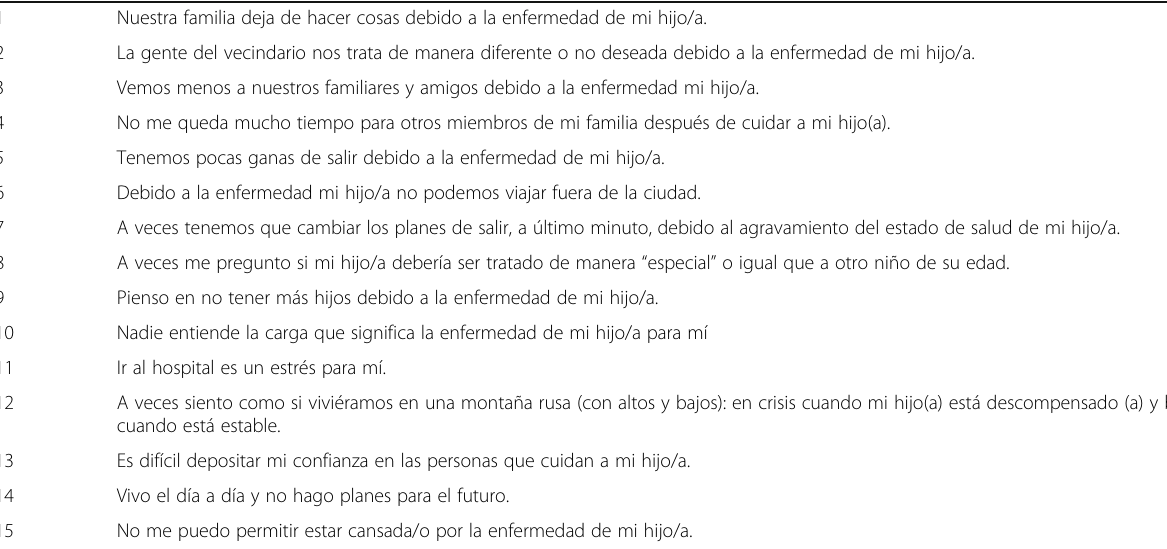
Table 2 Spanish hospital adapted version of the RIOFS